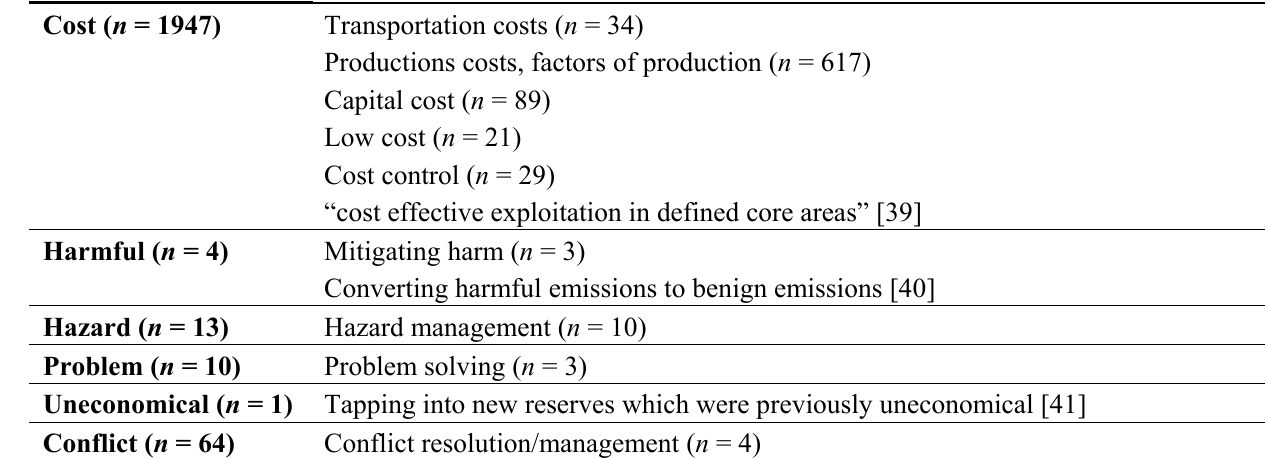
Table 4. Words used in a positive tone in industry